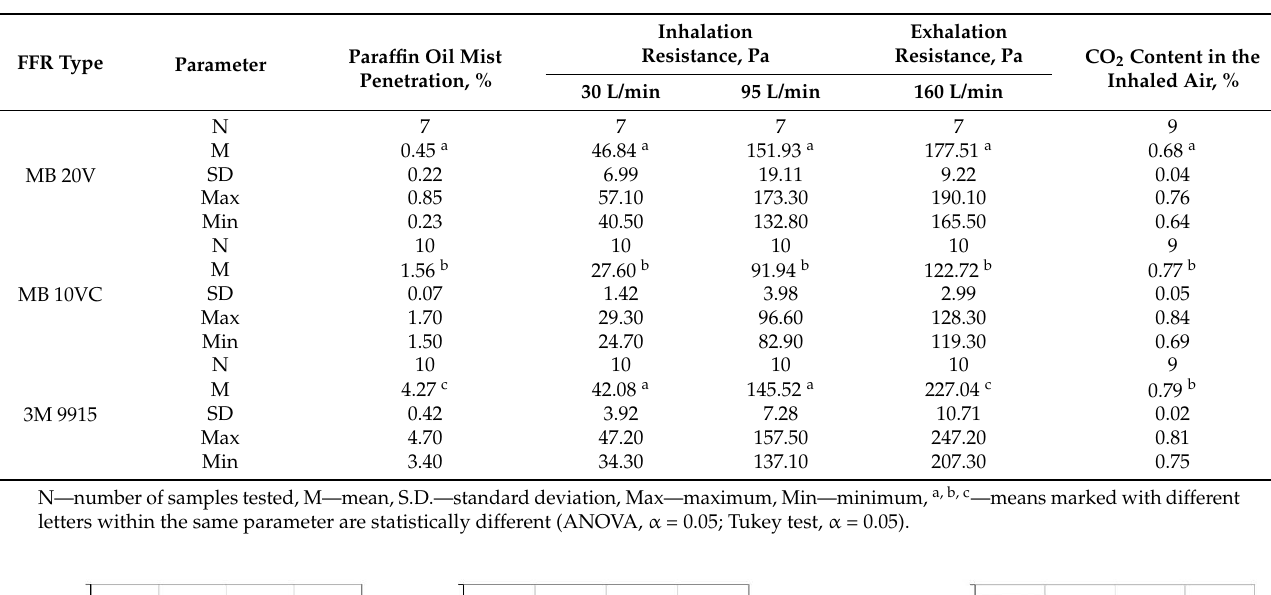
Table 2. Essential protection and functional parameters of the FFRs.